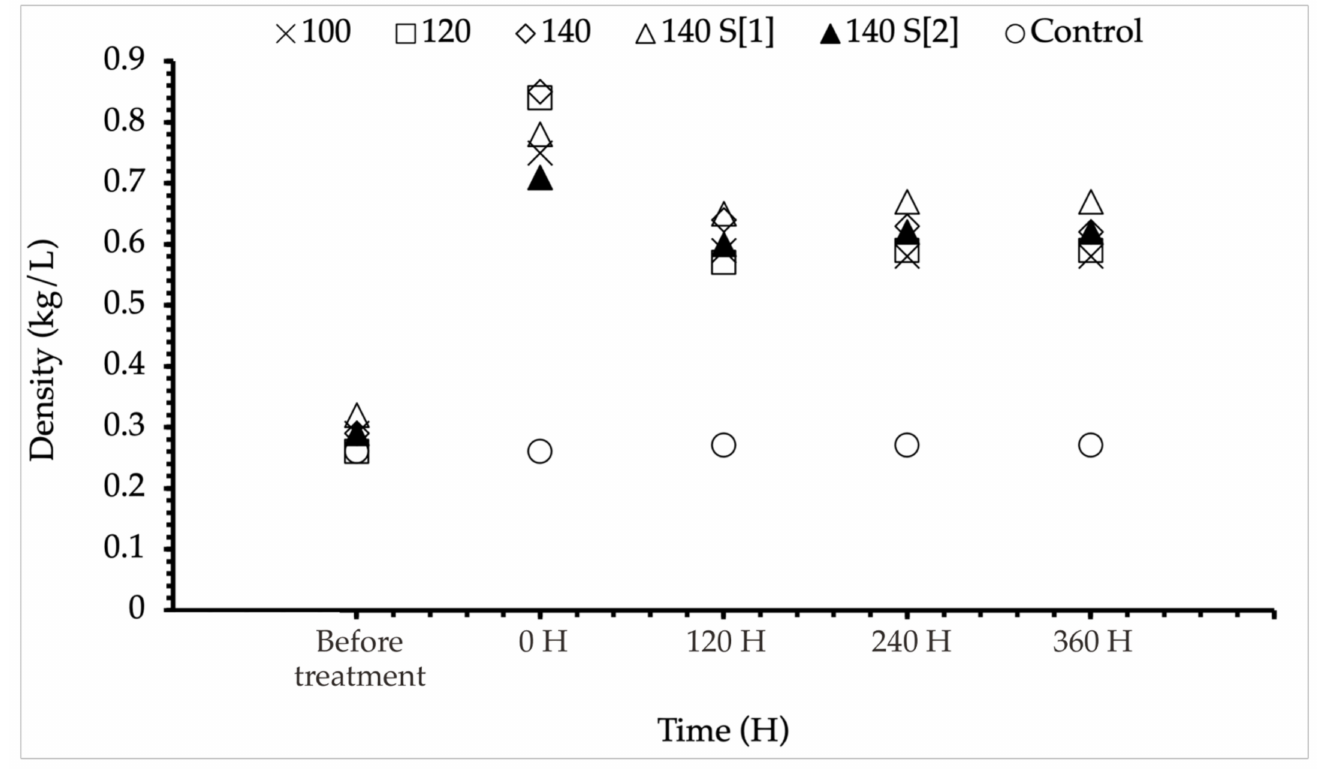
Figure 5. Density profile of